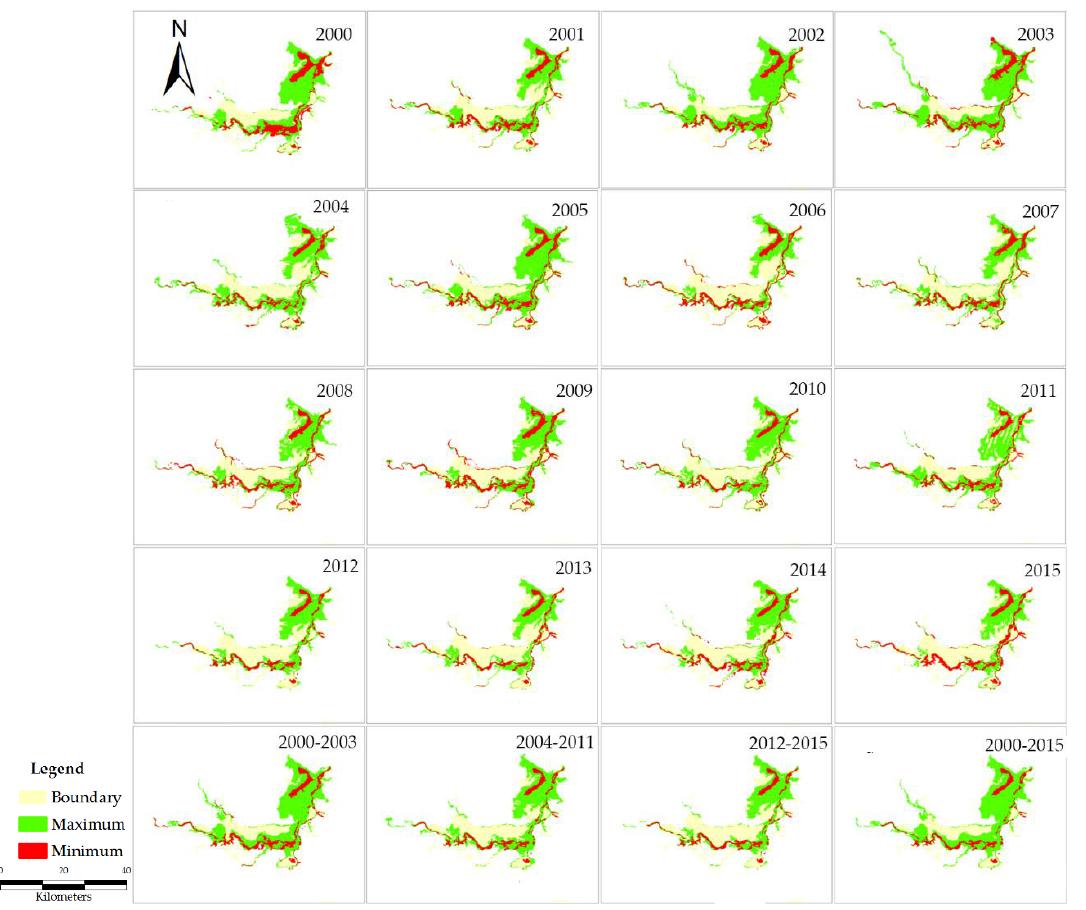
Figure 4. Annual maximum and minimum water area of Dongting Lake in 2000–2015.